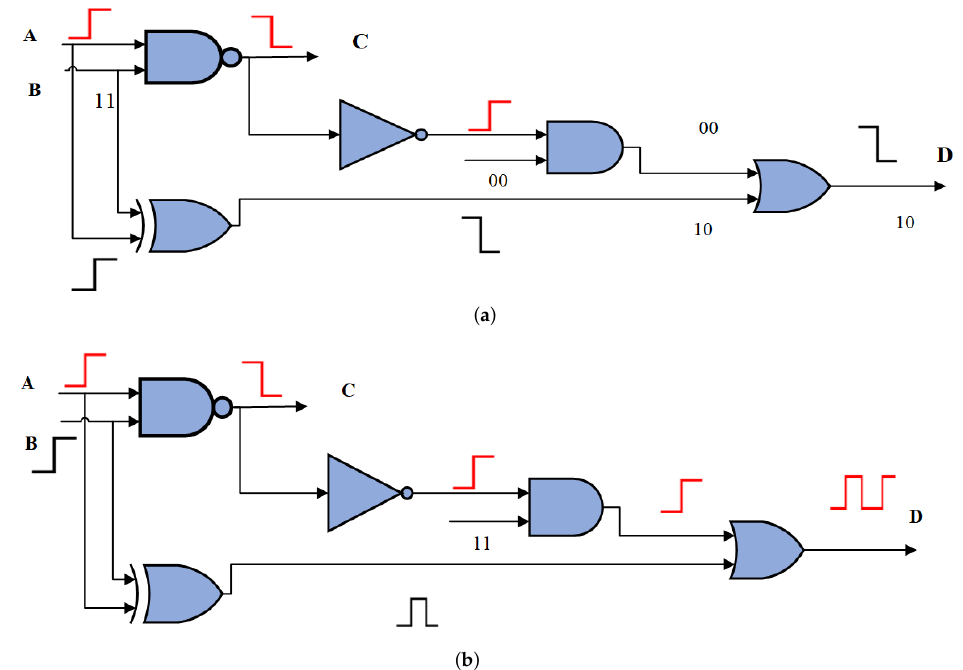
Figure 1. ( a ) TDF based pattern generation to propagate the fault at node A; ( b ) PDF based pattern generation for the path A to